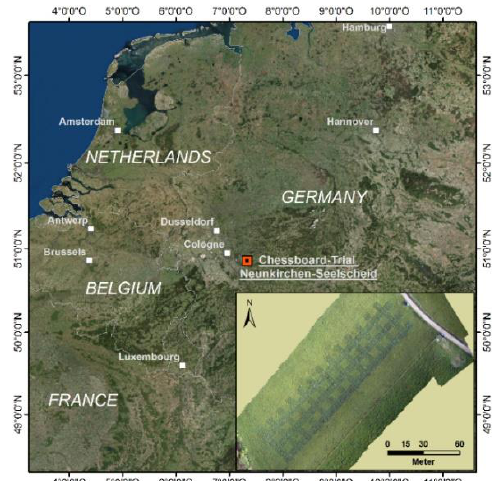
Figure 1. Location of test-site (data source: ESRI Basemaps, Eurostat). Inset map: Orthomosaic of test site.